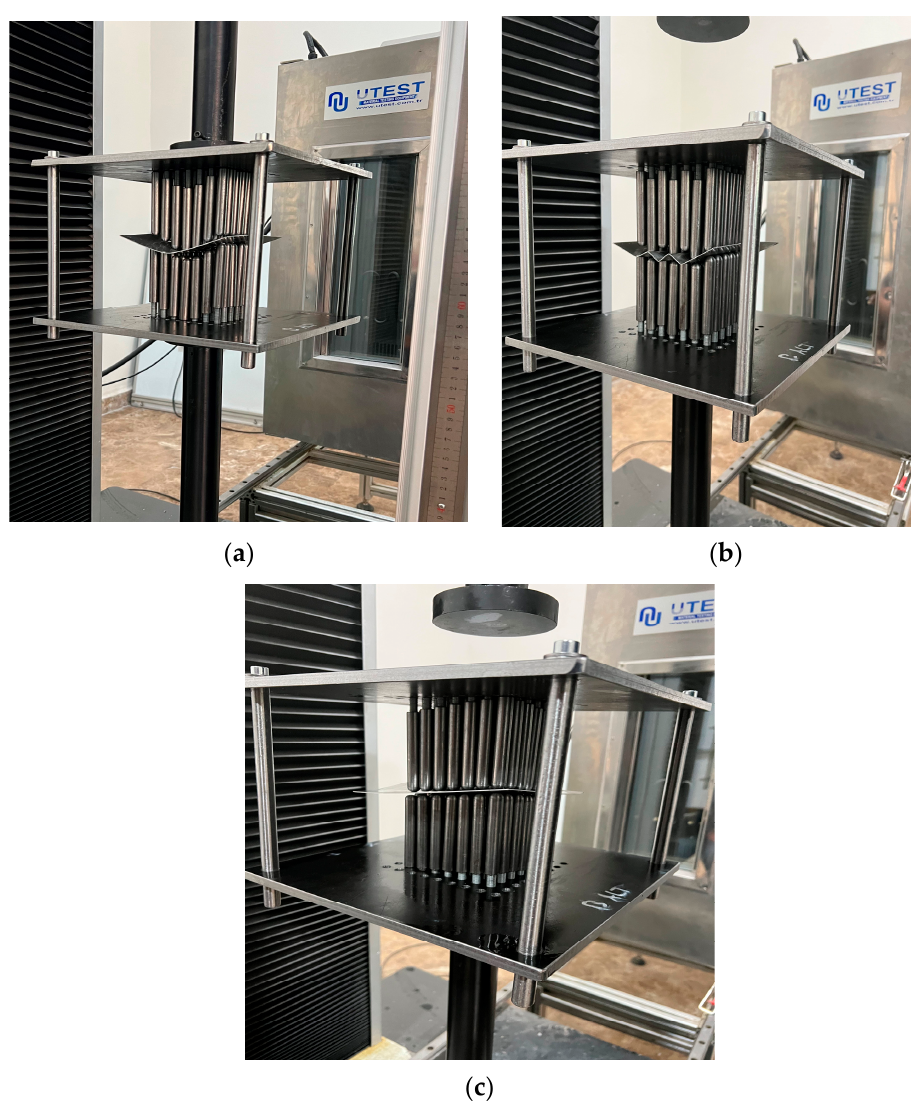
Figure 6. The photos of the sheets during forming with 12 mm diameter pins ( a ) form1; ( b ) form2; ( c )